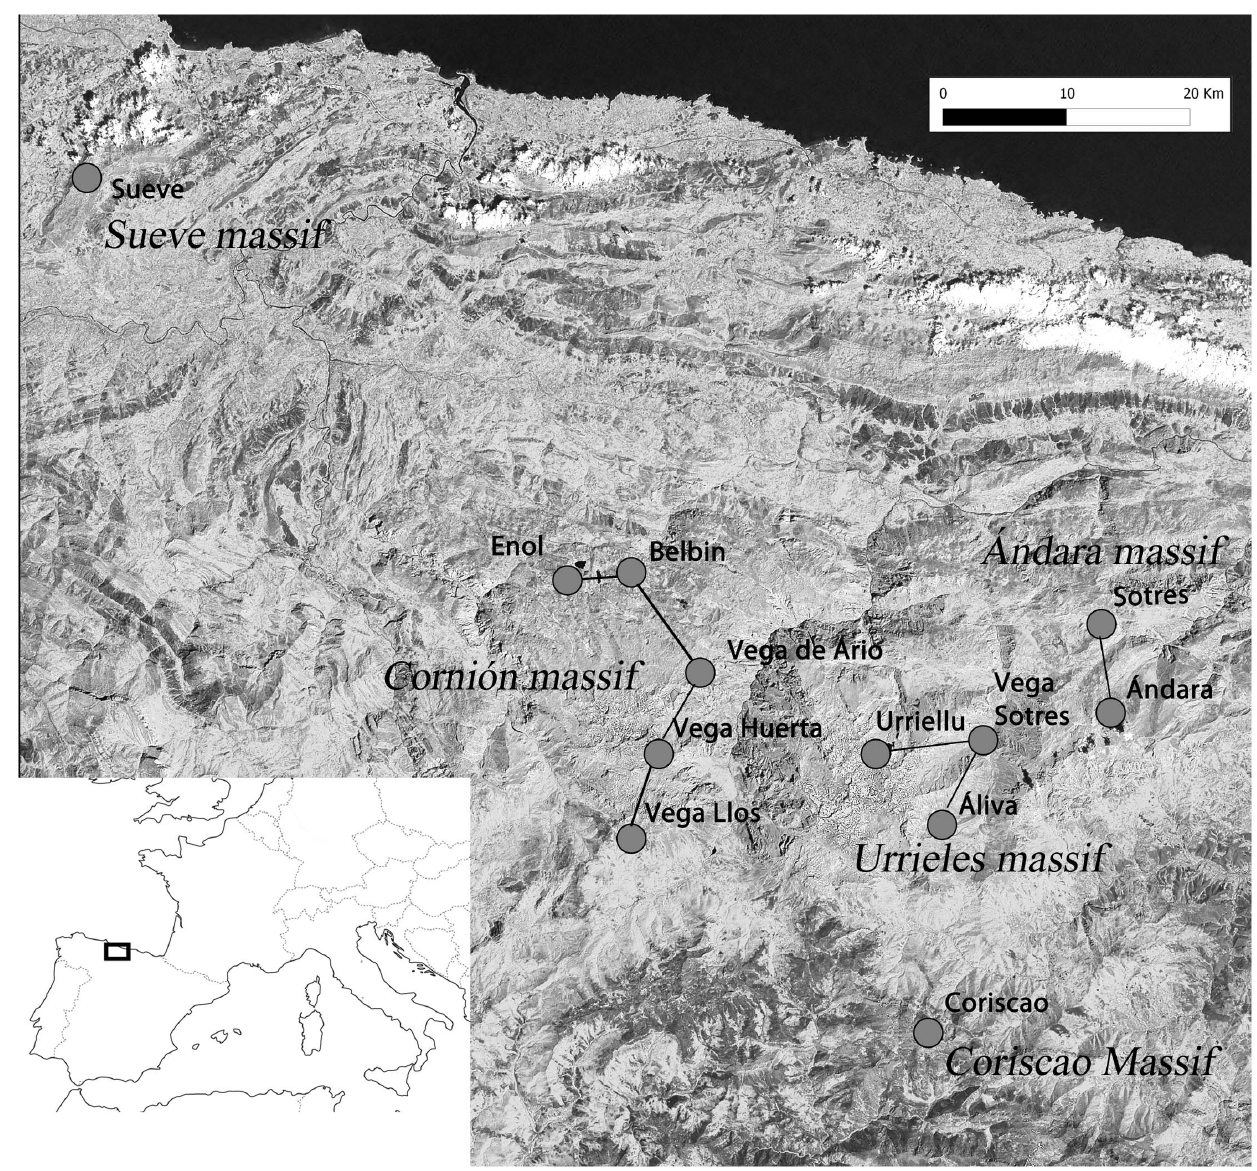
Figure 1. The study area. Map of the study area, depicting the five massifs and the 12 capture localities (grey dots).